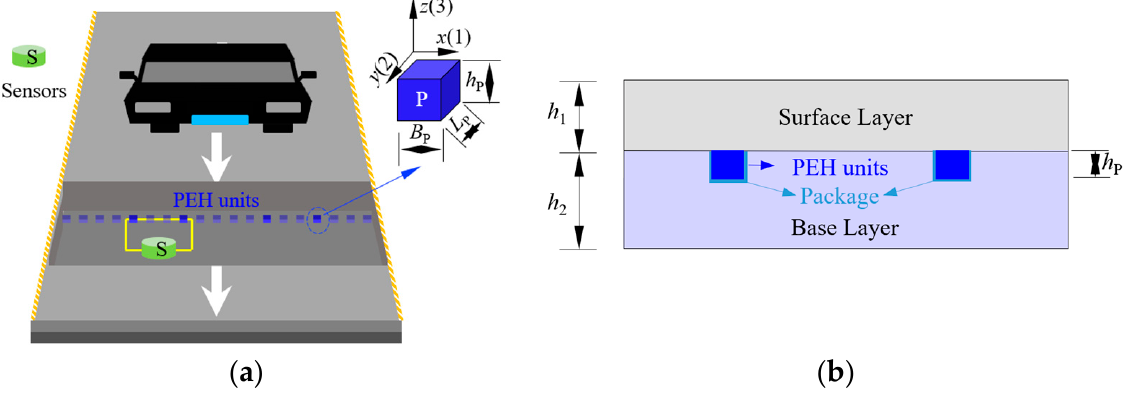
Figure 1. Schematic illustration of piezoelectric energy harvesting from pavement. ( a ) Piezoelectric energy harvester (PEH) units embedded in the road. ( b ) Transverse section view.